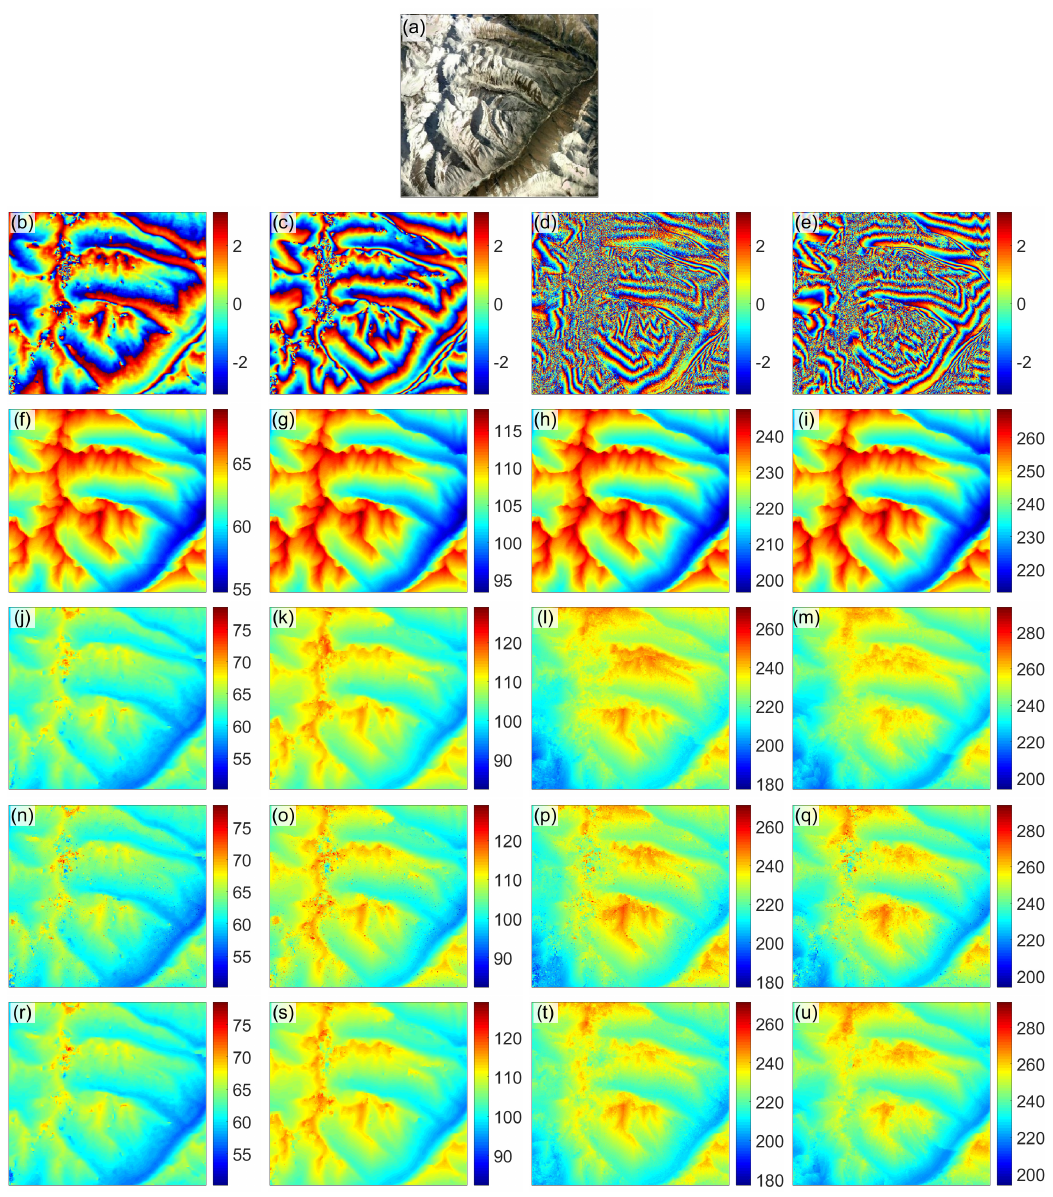
Figure 6. ( a ) Google Earth image of the study area. ( b – e ) ALOS PALSAR interferograms with different baseline lengths. ( f – i ) The Reference unwrapped phases of ( b – e ). ( j – u ) PU results of ( b – e ) obtained by ( j – m ) SB L 1 -norm, ( n – q ) MB TSPA, and ( r – u ) MB